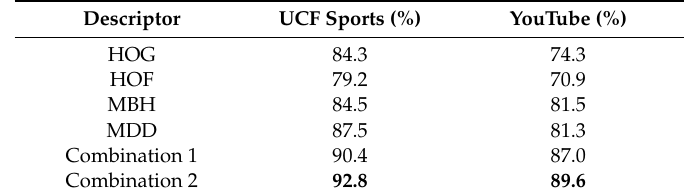
Table 1. Comparison of recognition results of different descriptors.